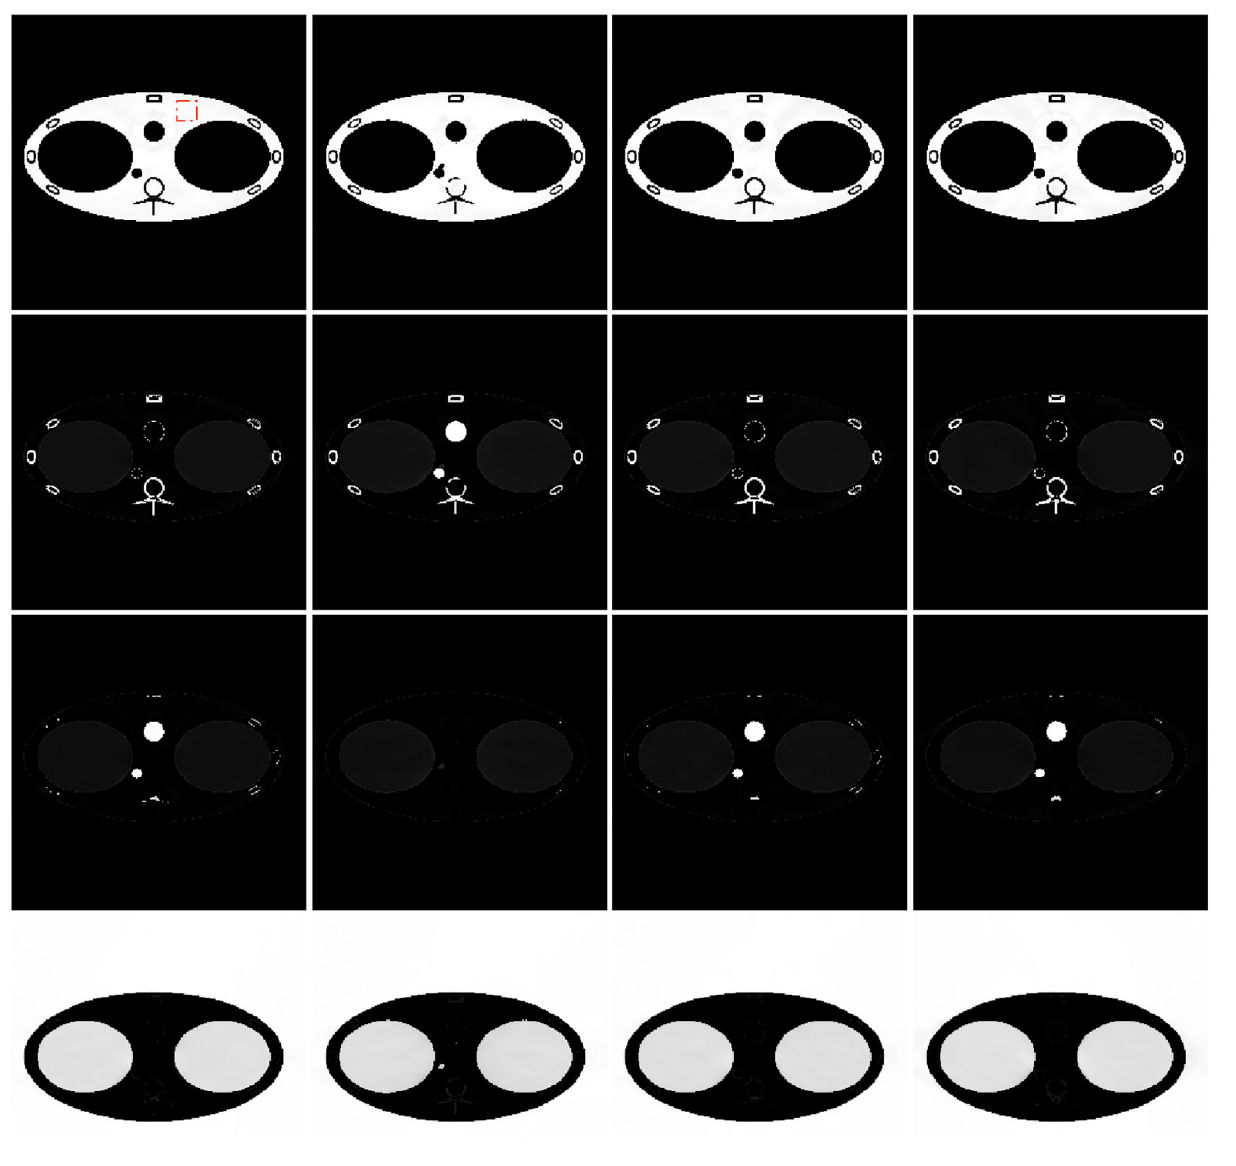
FIGURE 10 | Decomposition results of different algorithms and body materials. From top to bottom: soft tissue, bone, blood, and iodine, air. From left to right: scatter-free full-view (scatter-free-FV) results, scattered (scattered-FV) results, scatter corrected (scattered-corrected-FV) results, triple plane CT (TPCT) results. Display windows is [0,